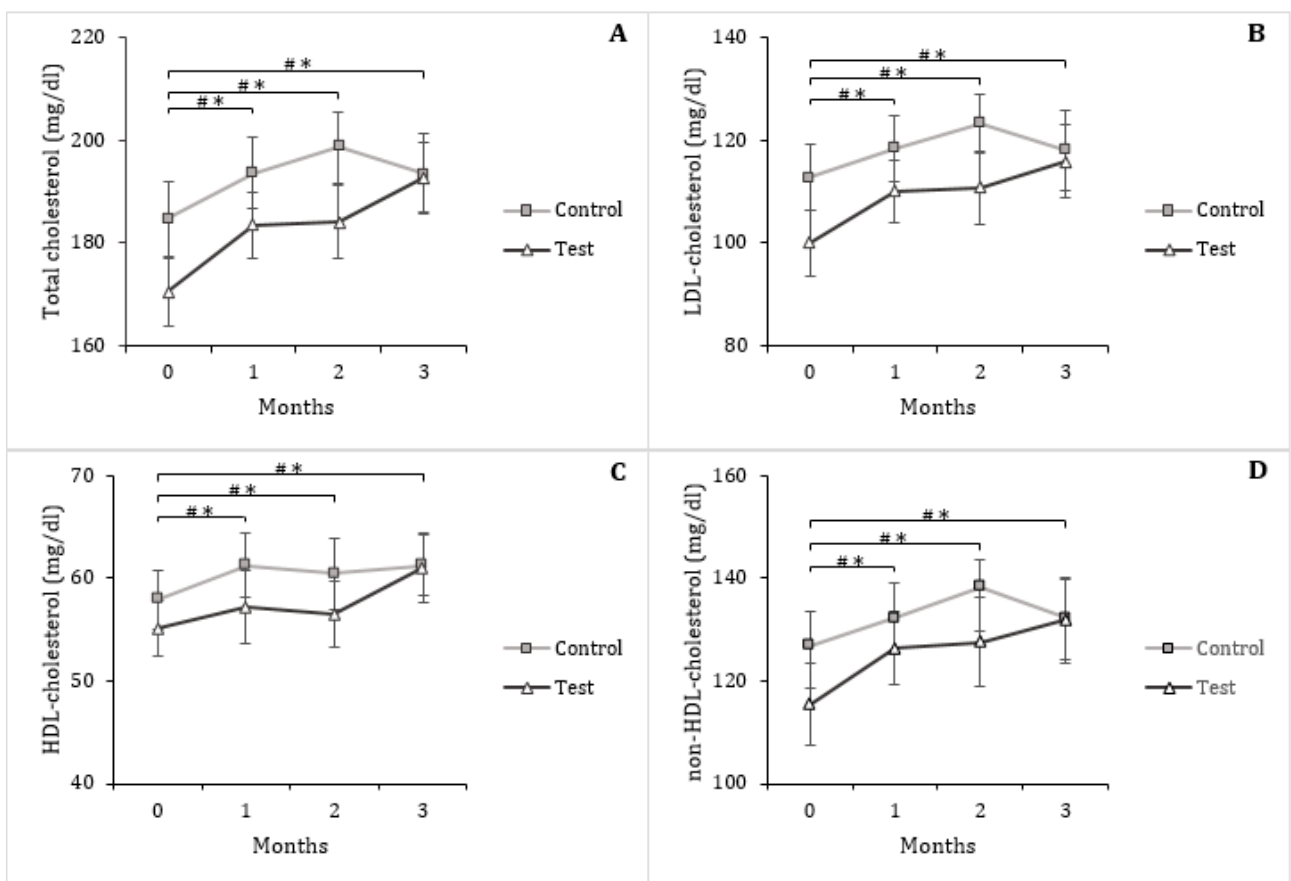
Figure 4. Total cholesterol ( A ), low-density lipoprotein (LDL)-cholesterol ( B ), high-density lipoprotein (HDL)-cholesterol ( C ) and non-HDL-cholesterol ( D ) in response to the daily consumption of two eggs enriched in oleic acid (OA) by the control group ( ⧠ ) or two eggs enriched in α -linolenic acid (ALA), docosahexaenoic acid (DHA), rumenic acid (RmA) and punicic acid (PunA) by the test group ( ∆ ) during 3 months. Mean (± SEM). Paired t-test, p < 0.001. (#) Significant difference compared to month 0 within the control group; (*) Significant difference compared to month 0 within the test group.